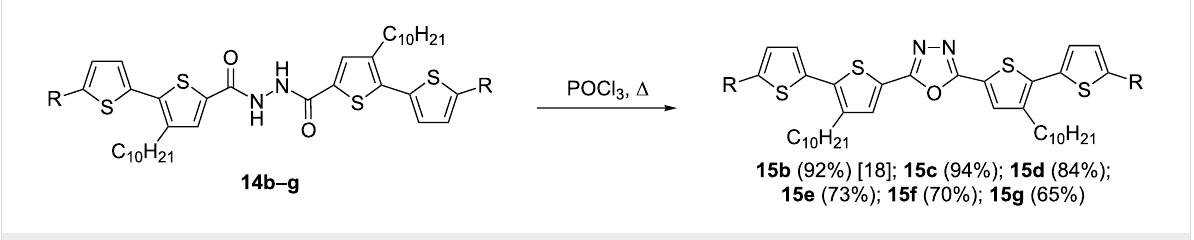
All intermediates and final products were identified by elemental analysis, NMR and IR spectra, which are presented in Supporting Information File